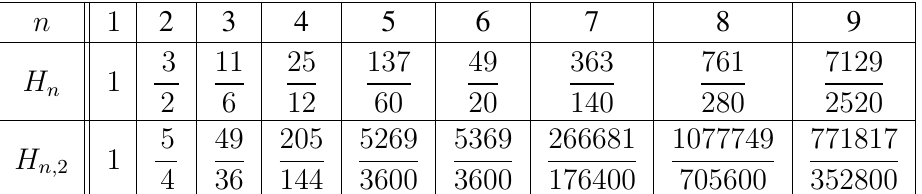
and generalized harmonic numbers H n cosh x , x (cid:54) = 0 coth x = sinh x